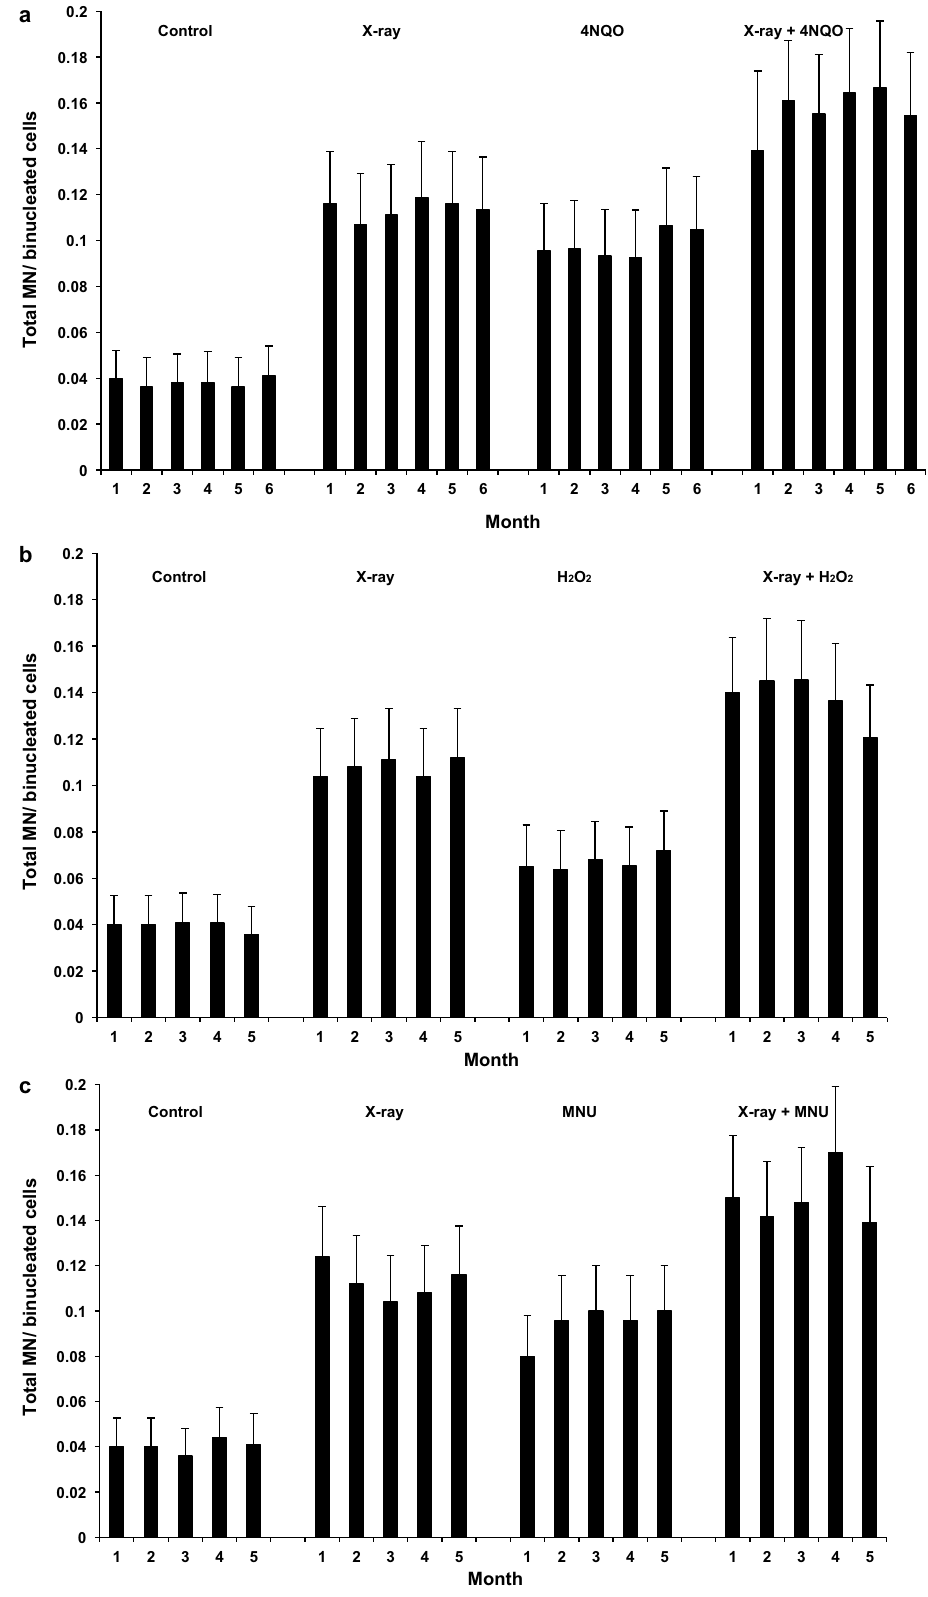
Figure 7. Micronuclei (MN) per binucleated cell after 1–6 months of chronic exposure to 20 ng/ml 4NQO or sham-exposure and/or acute exposure to 1 Gy X-rays ( a ), 10 μM H 2 O 2 or sham-exposure and/or acute exposure to 1 Gy X-rays ( b ), 0.25 μg/ ml MNU or sham-exposure and/or acute exposure to 1 Gy X-rays ( c ). Between 115 and 275 binucleated cells were scored per data point for ( a ), between 200 and 270 cells for ( b ) and between 200 and 250 cells for ( c ). Error bars are Poisson